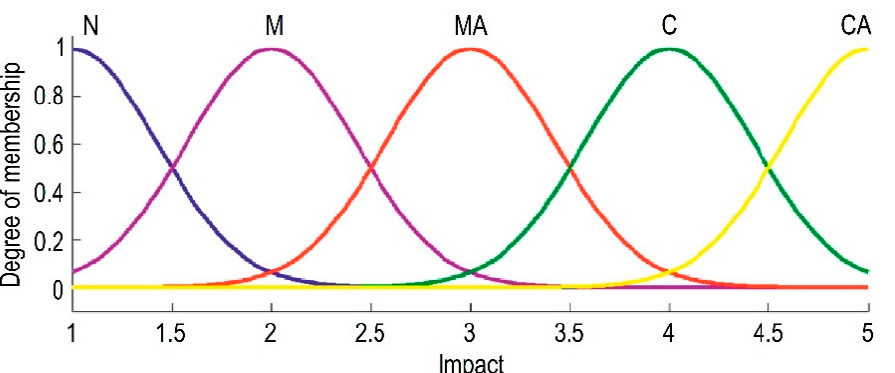
Figure 4. Membership function for the influence level.